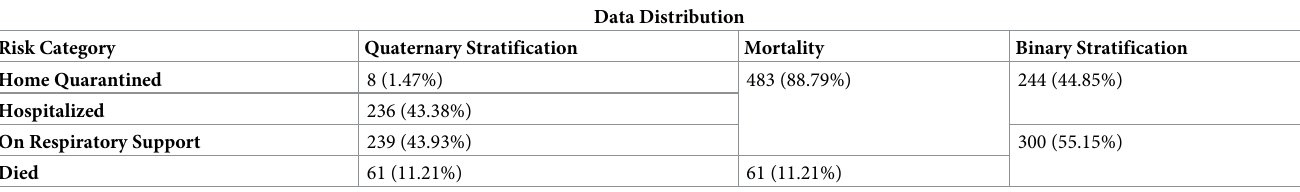
Table 1. Distribution of the number of patients across various